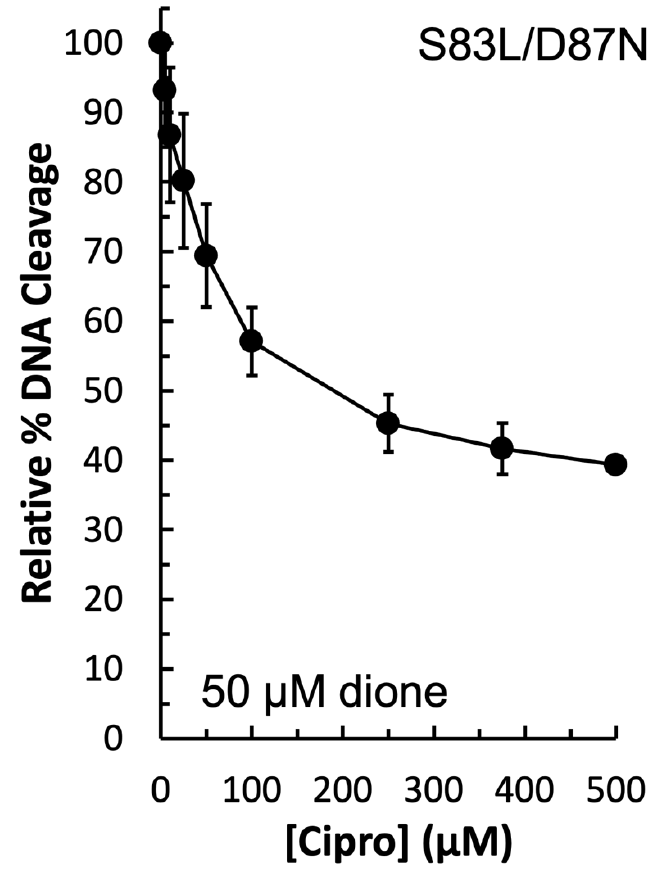
Figure 7. Competition between ciprofloxacin and the quinazolinedione to induce plasmid DNA cleavage by GyrA S83L/D87N gyrase. An amount of 50 µM quinazolinedione (the concentration at which maximal cleavage was achieved with this drug–enzyme combination) was included simultaneously in all reactions with 0 – 500 µM ciprofloxacin to determine the ability of the quinolone to compete with the quinazolinedione for interaction with the enzyme. The level of cleavage seen in the presence of the quinazolinedione alone was set to 100%. Error bars represent the standard deviation of three independent experiments.